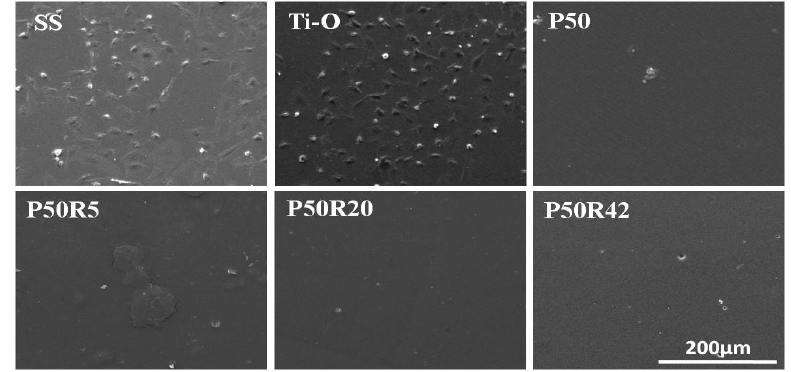
Figure 6. SEM images of endothelial cells after culture on the SS, Ti–O, P50, P50R5, P50R20, and P50R42 sample surfaces for 1 day.